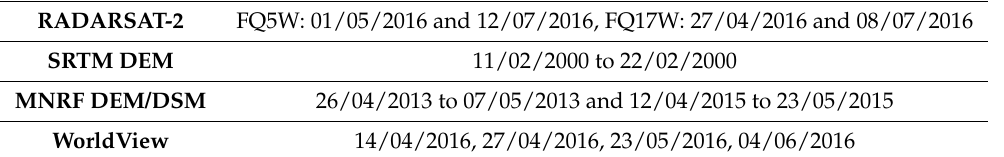
Table 2. Acquisition dates of the data used in this research